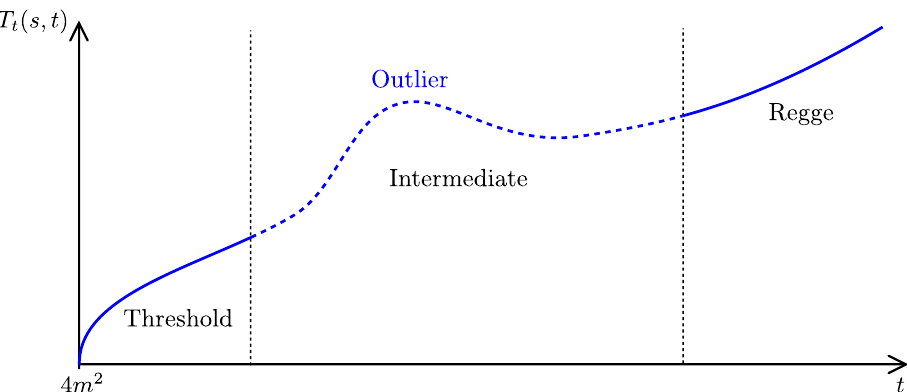
Figure 12 . The error in our approximation for the inelasticity depends on our knowledge about the discontinuity of the amplitude T t ( s, t ) . Here, the discontinuity is plotted for different energy scales ( t ) at fixed s . Its structure in the large energy (Regge) and the low energy (threshold) regions are under relatively good control (solid blue line). At intermediate energy scales the amplitude may develop a bump. The problem of outliers is the problem of bounding the discontinuity in this regime, and hence bounding our error for the